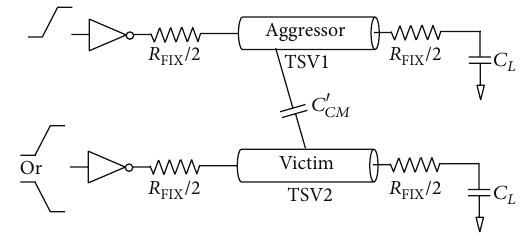
Figure 5: Capacitively coupled via